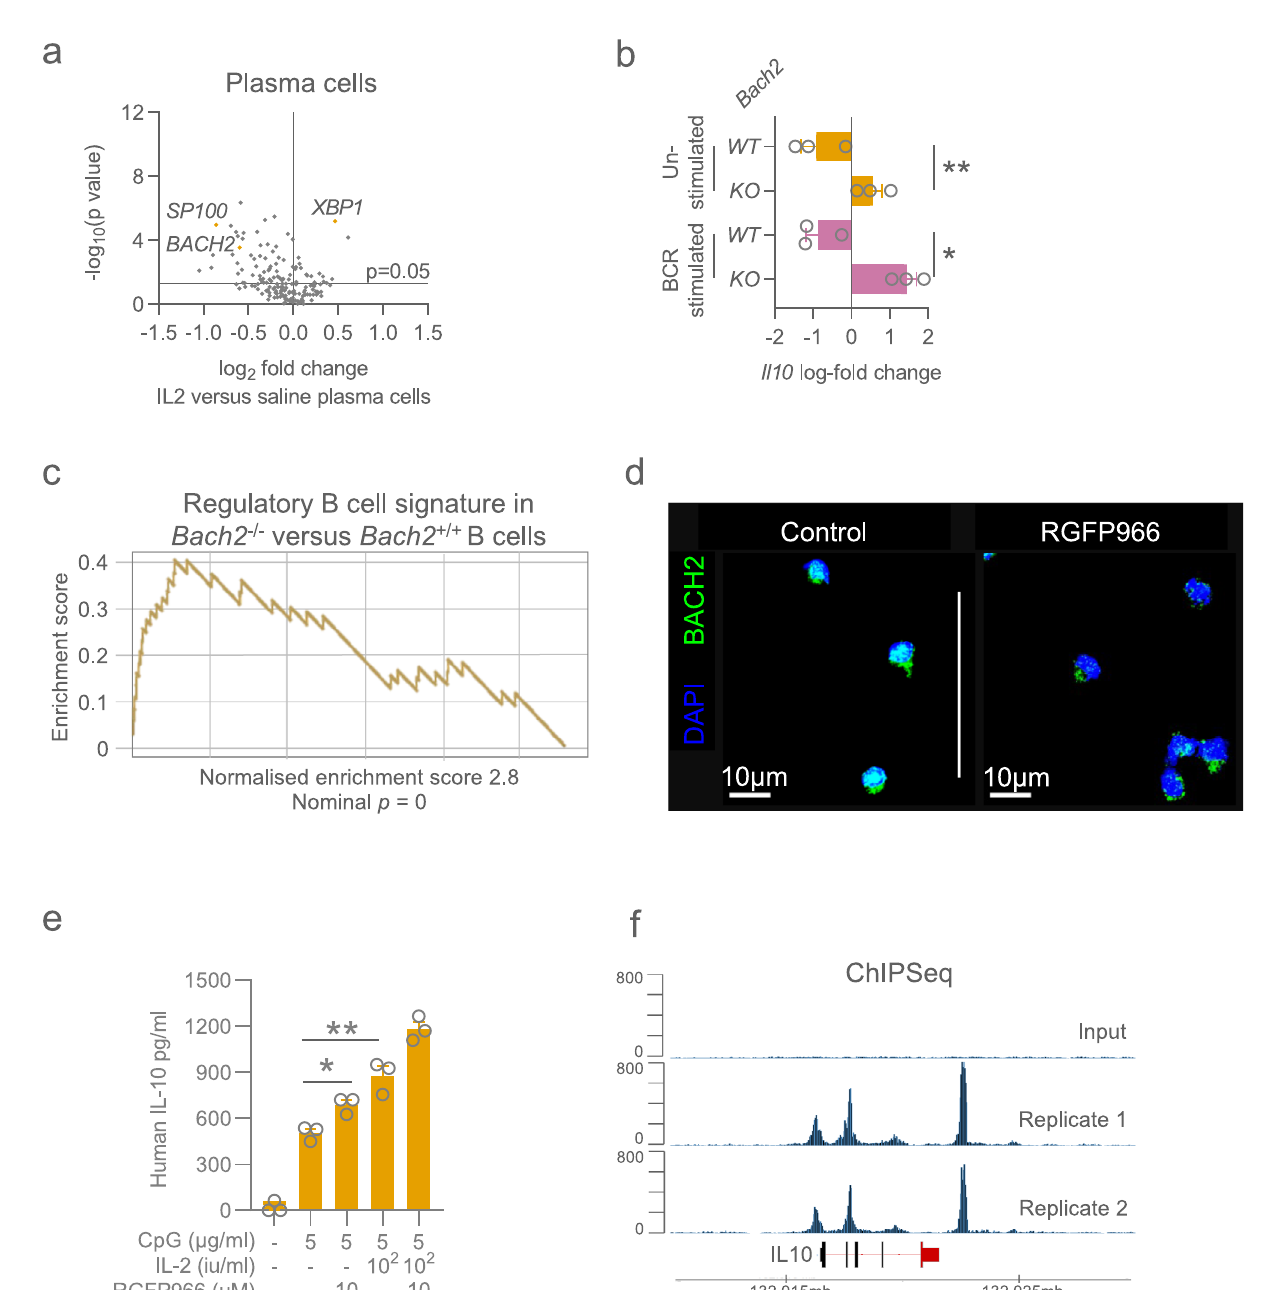
scRNAseq: Naïve, non-switched memory and switched memory B cells and plasma cells (left). Dot plot of enriched identifying genes of each cluster (right). e Proportion of each cell type before treatment and following saline or LD IL-2 treatment. LD IL-2 treatment groups combined. p -values generated using an unpaired two-tailed parametric t -test. ** p <0.01 ( f ) Dotplot showing Breg gene set enrichment (gene signatures from recently published meta-analysis of all human BregRNAseqstudies).Theintensityofgenesignatureexpressionisindicatedbythe colour of the dot and proportion of cells expressing this signature is indicated by size of the dot. Source data are provided as a Source Data fi le.